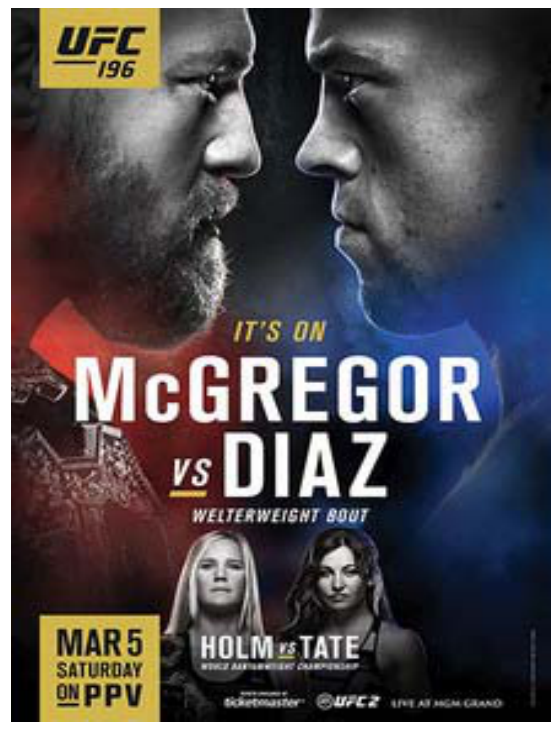
Fig. 1. Promotional Poster UFC 196